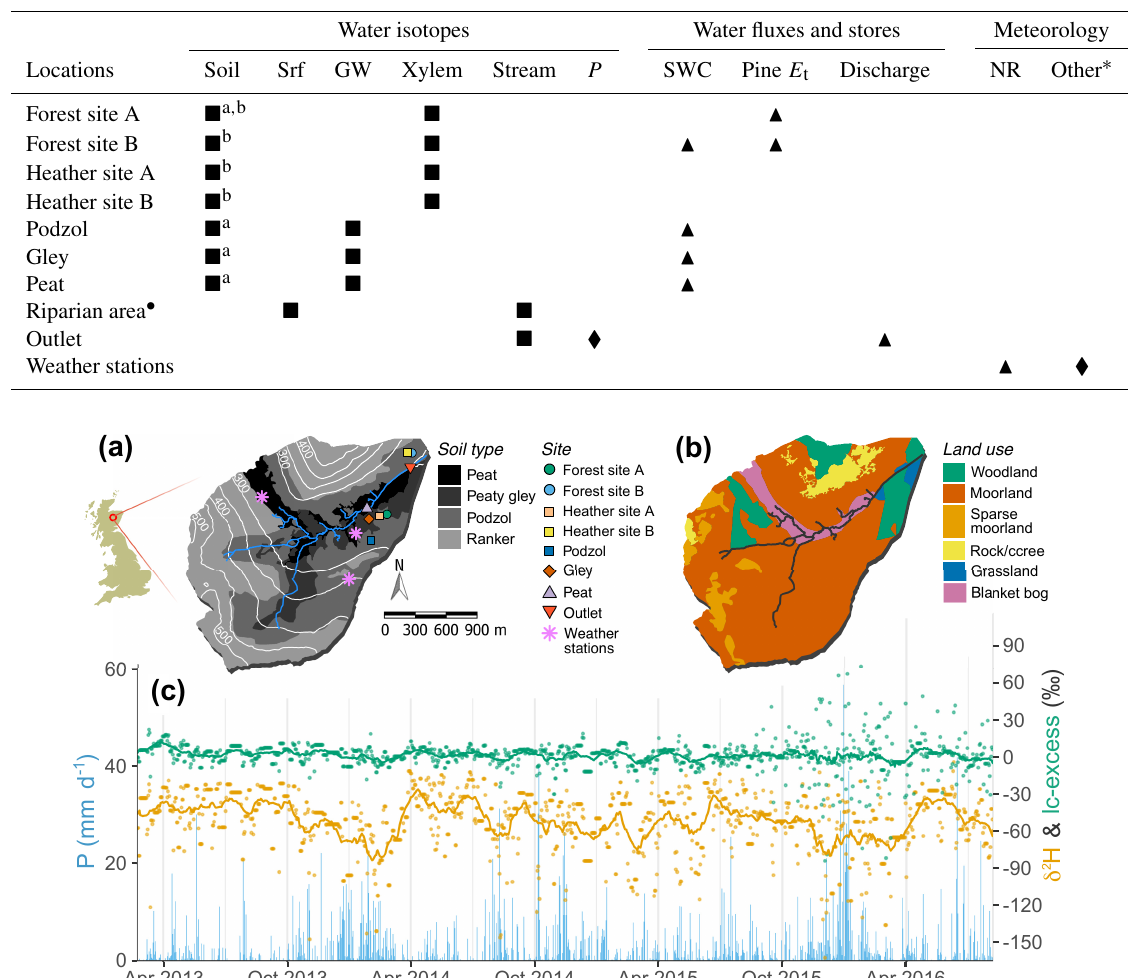
Figure 2. Bruntland Burn catchment characteristics, showing (a) topography, soil cover as derived from the Hydrology of Soil Types (HOST) classification types, stream network, and measurement site locations, and (b) land use type. (c) Time series of measured precipitation amount (blue bars, daily) and isotopic signatures, δ 2 H (orange) and lc-excess (green), showing daily values (dots) and the 30-day running mean (solid